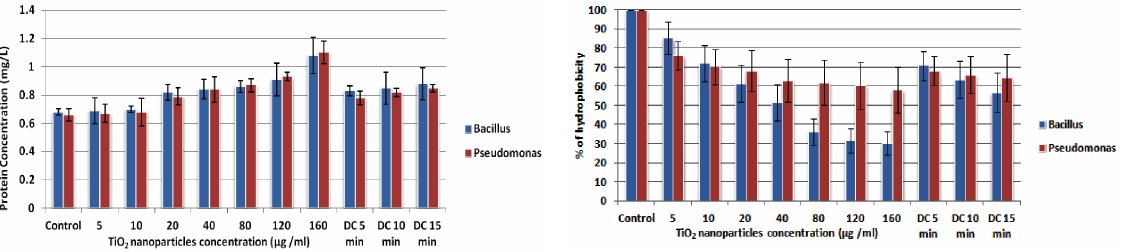
Figure 9: The effect of TiO 2 -NP concentrations (5-160 µ g/mL) and DC exposure (5, 10, and 15 min) on the hydrophobicity percentage of B. cereus and P. aerugi- nosa biofilms.